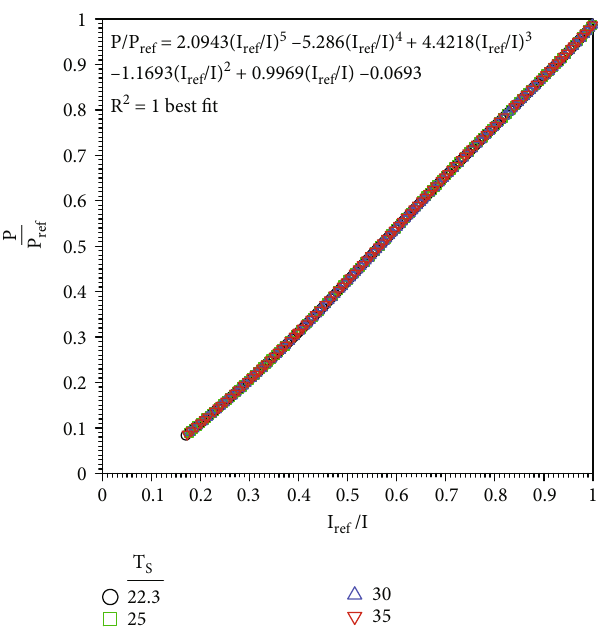
Figure 6: Calibration curve at di ff erent temperatures: 22.3, 25, 30, and 35 °